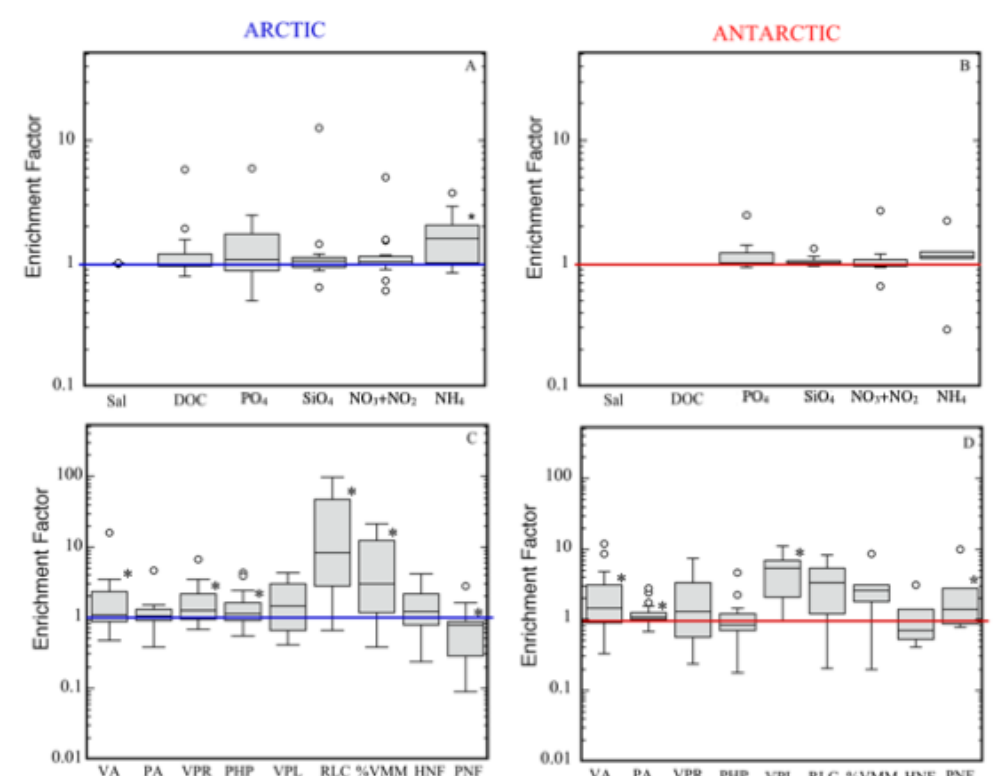
Figure 2. Box-whisker plots of enrichment factors in Arctic and Antarctic waters. Chemical variables (Sal: salinity; DOC: dissolved organic carbon; PO 4 : phosphate; SiO 4 : silicate; NO 3 +NO 2 : nitrite plus nitrate; and NH 4 : ammonia concentrations) ( A , B ). Microbial parameters (VA: viral abundance; PA: prokaryote abundance; VPR: virus prokaryote ratio; VPL: viral lytic production; RLC: rate of lysed cells; %VMM: virus-mediated mortality; HNF: heterotrophic nanoflagellate abundances; and PNF: phototrophic nanoflagellate abundances) ( C , D ). Horizontal lines within boxes indicate the median of the distribution, and the box limits are 25% quartiles of the data. The whiskers cover the entire data range, except for outliers (°), some of which are off-scale. * Significant EF values different than 1. The horizontal line in each figure corresponds to EF = 1.